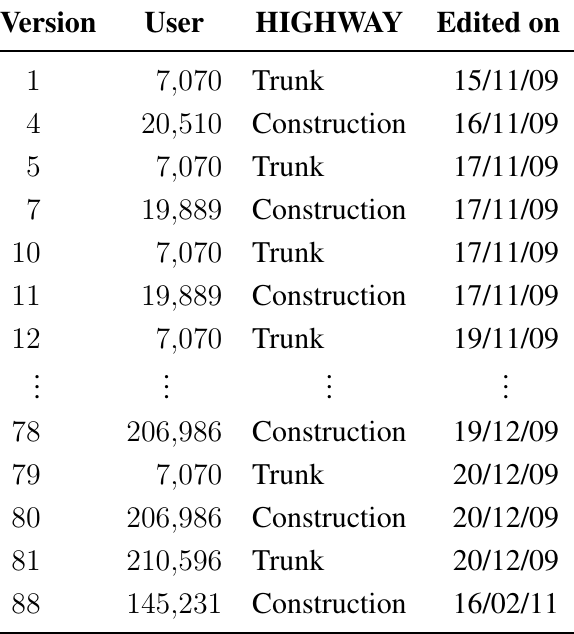
Table 4. Example of a “tag war” among OSM contributors in Germany. The value of the HIGHWAY tag representing a road feature is frequently reverted back by its original contributor. The OSM-ID of this feature is 23 ; 704 ; 273